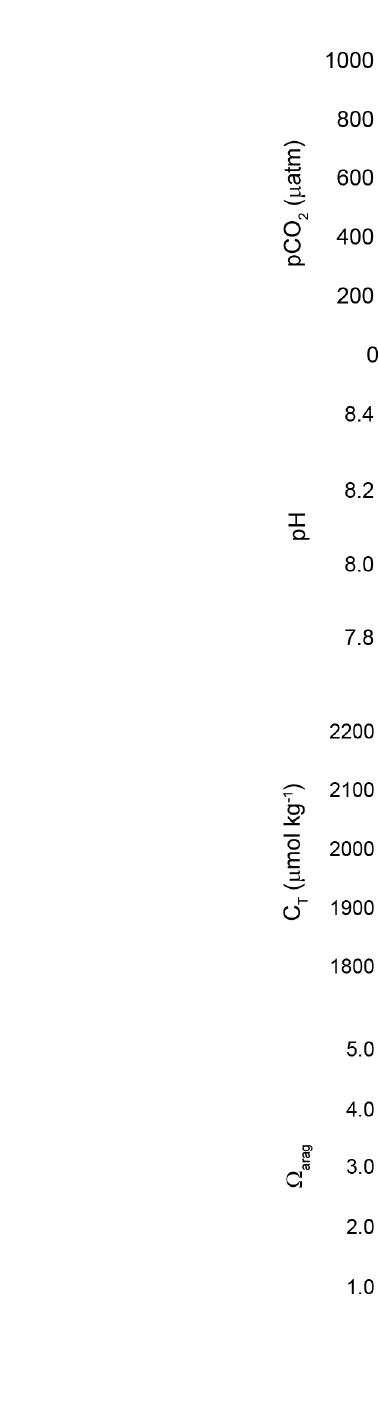
FIGURE 3 Temperature dependence of seawater carbonate parameters: (A) pCO 2 , (B) pH, (C) C T , and (D) W arag . Thermodynamic changes with varying temperature in the closed system (red lines) are calculated at the constant values of C T (2001.9 μmol kg − 1 ), A T (2239.2 μmol kg − 1 ), and salinity (33.5), which were the mean concentrations of the discrete measurements. Theoretical changes in the equilibrated system (black lines) are estimated under the assumption of complete equilibration of pCO sw 2 with pCO air 2 (415.0 μatm) (with the constant A T of 2239.2 μmol kg − 1 ). Colored circles overlaid by month indicate the measured values of carbonate parameters at in situ conditions during the discrete measurements (2019 −